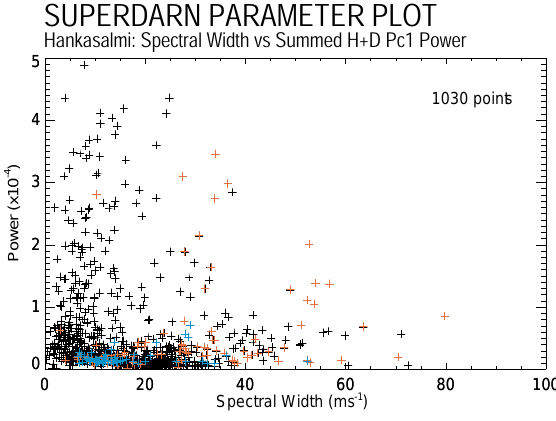
Fig. 9. A comparison of summed H -and D -component Pc1 power measured by KIL and the mean spectral width measured by CUT- LASS across the region of artificial scatter observed along beam 5 of the Finland radar. The total data set (black pluses) were de- rived from all OUCH experiments in the years 1998–9 and rep- resent 1-min averaged values (1030 points in total) on all occa- sions when data were available. Also highlighted are the data com- piled from Figs. 3, 7 and 8 when the spectral widths were very low (blue pluses) and increased coincident with Pc4 wave activity (red